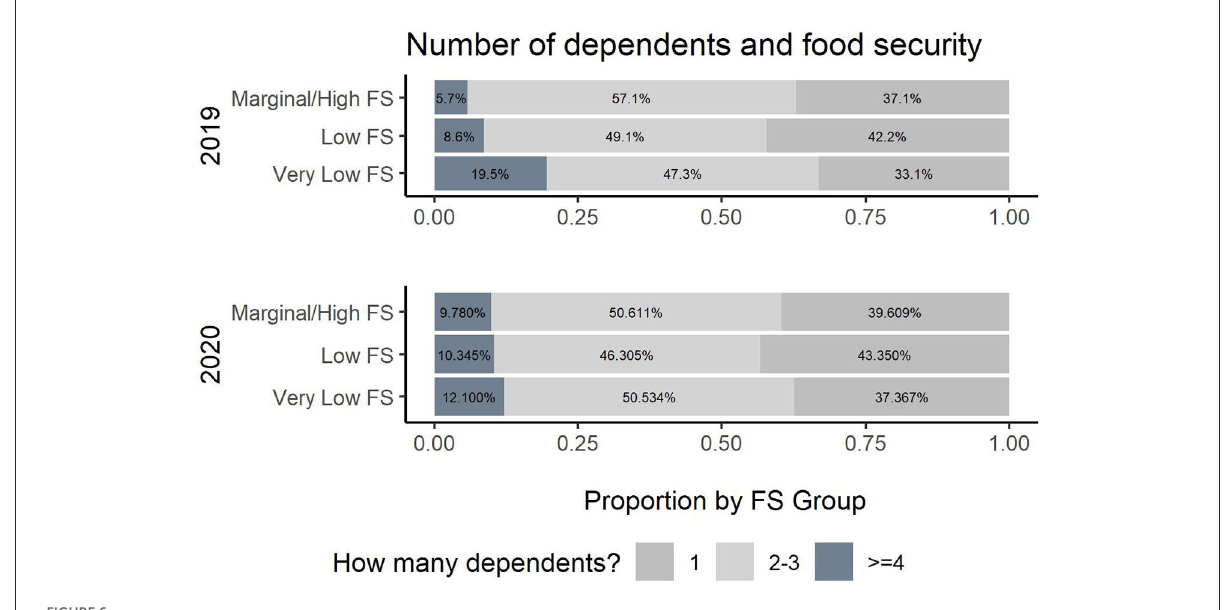
FIGURE6 Number of dependents and food security.